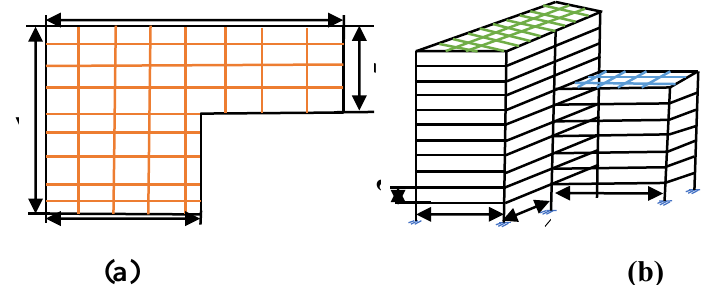
Fig. 1 . (a) Plan & (b) Elevation of the 10 storey unsymmetrical